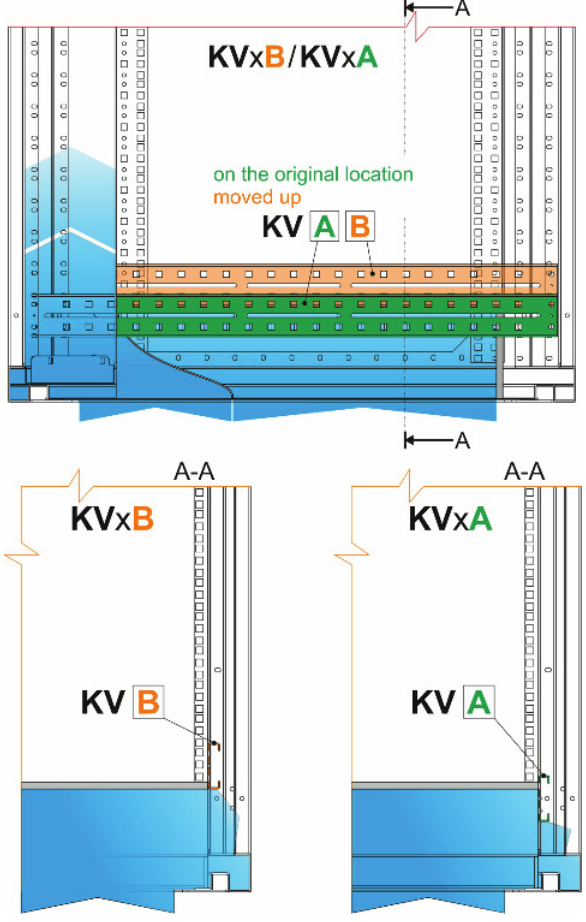
Fig. 4. Side cooling zones configuration for di ff erent position of side bar.